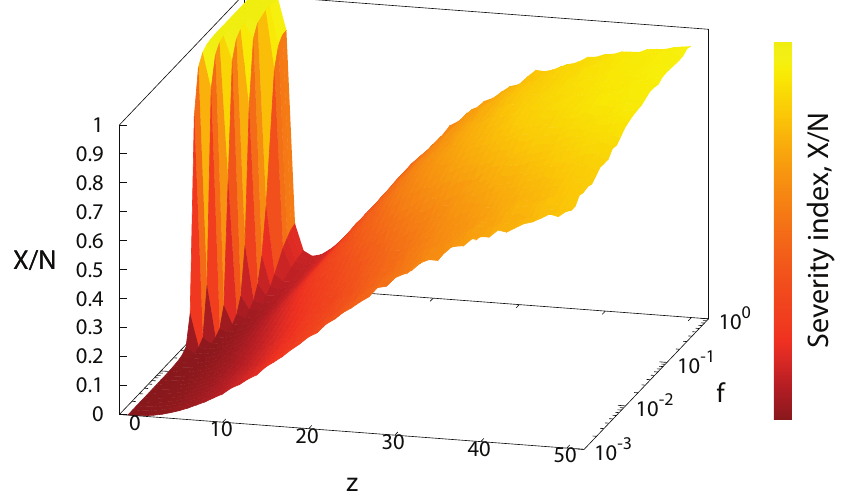
Figure 2. Severity index, X, as a function of the infection rate per contact f and the control neighborhood size z . Simulation parameters: q ~ 0 : 5 , v , r ~ 0 : 1 with 40 initial foci and infected neighborhood size set to z inf ~ 1, cost c ~ 1 :